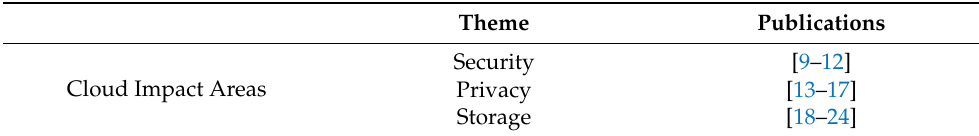
Table 1. Blockchain impact areas in Cloud